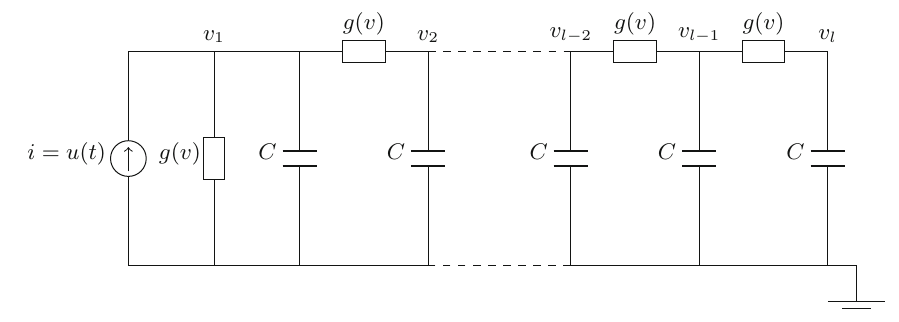
Fig. 1 Nonlinear RC circuit Table 1 Error estimation results for RC circuit No. of iterations Interpolation